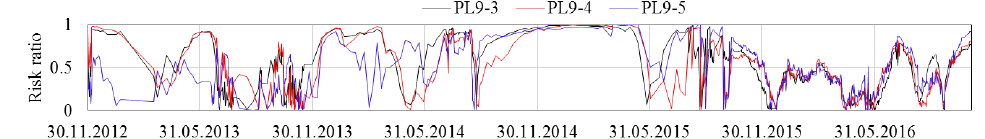
Figure 17. Displacement risk ratios for monitoring points PL9-3, PL9-4 and PL9-5.